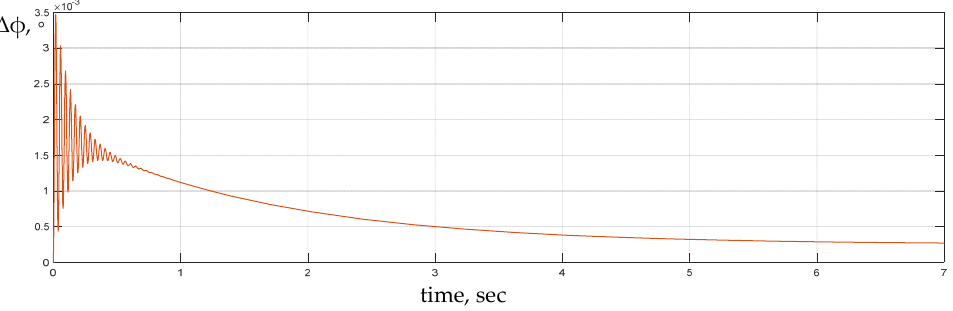
Figure 6. Dependence of the twist angle change Δϕ during acceleration for γ = 2.